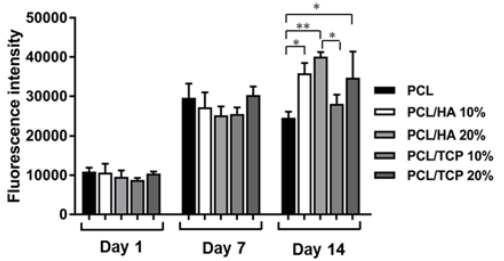
Figure 8. Fluorescence intensity for all different scaffolds at day 1, day 7, and day 14. ∗ p < 0.05 and ∗∗ p < 0.01 using one-way analysis of variance (ANOVA) with Tukey test.